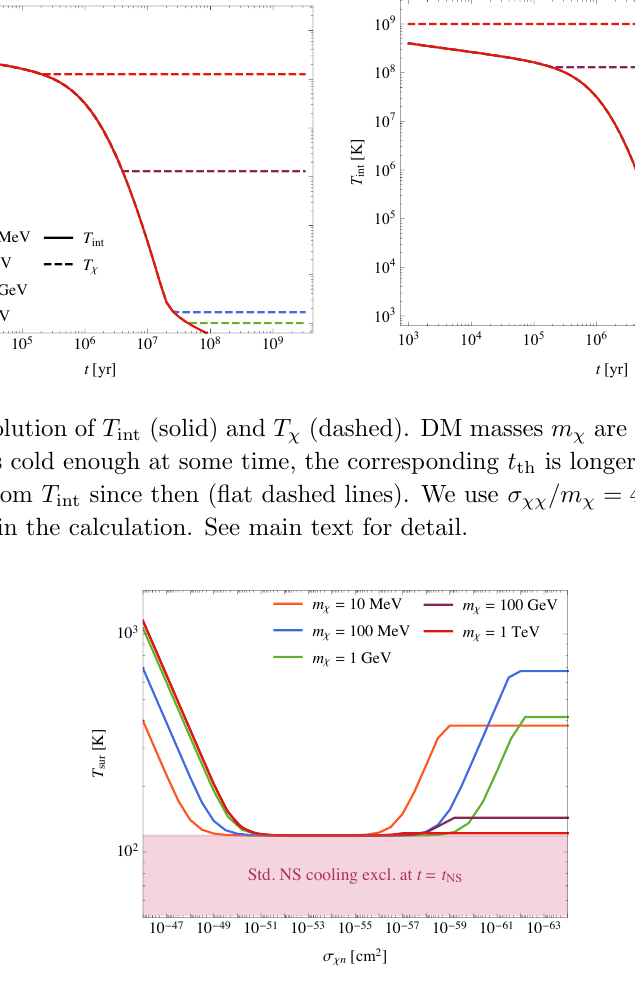
Figure 2 . NS surface temperature T sur versus (cid:27) (cid:31)n at t = t NS . DM masses m (cid:31) are marked with di(cid:11)erent colors and f (cid:31) = 1. We use (cid:27) (cid:31)(cid:31) =m (cid:31) = 4 cm 2 g (cid:0) 1 and h (cid:27)v i = 3 (cid:2) 10 (cid:0) 26 cm 3 s (cid:0) 1 in this